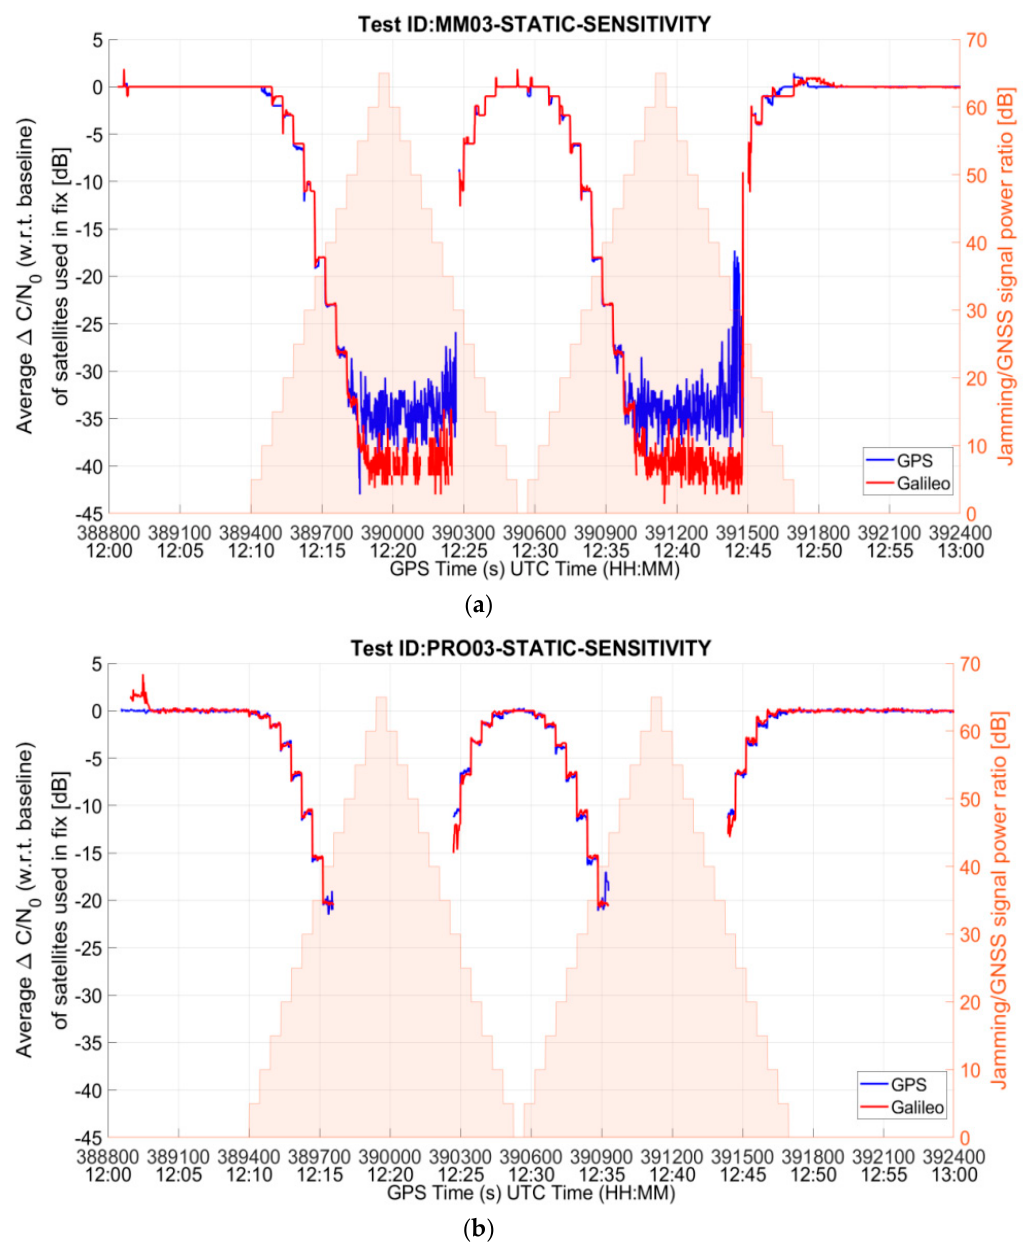
Figure 9. Drop in average C/N 0 for ( a ) MM RUT and ( b ) PRO RUT in the presence of threat signature 03 when C/N 0 default settings are used in the receivers.